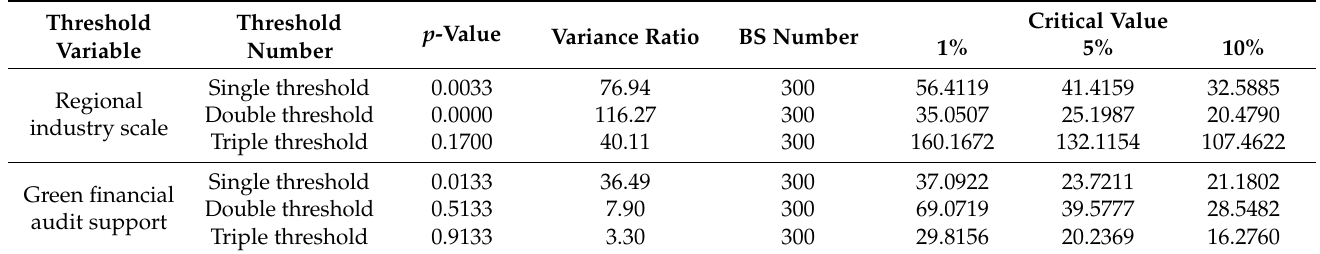
Table 5. Threshold effect test.